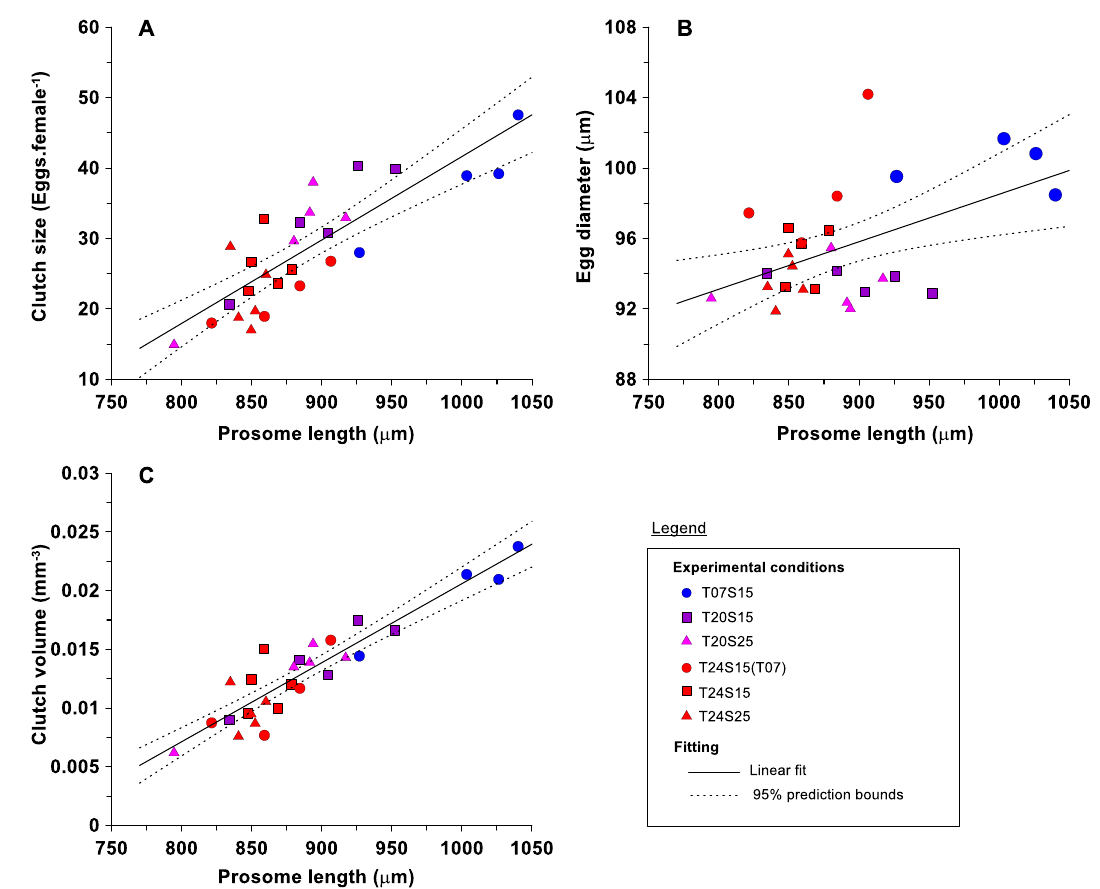
Figure 3. Relationship between E. affinis female prosome length with clutch size ( A ), egg diameter ( B ) and clutch volume ( C ). The rectangles contain the labels of each population used from laboratory experiments as shown in the flow chart of Fig. 1. The solid line is the regression line and the dashed lines indicate the 95% confidence interval. The results of the regression analyses were indicated in Table